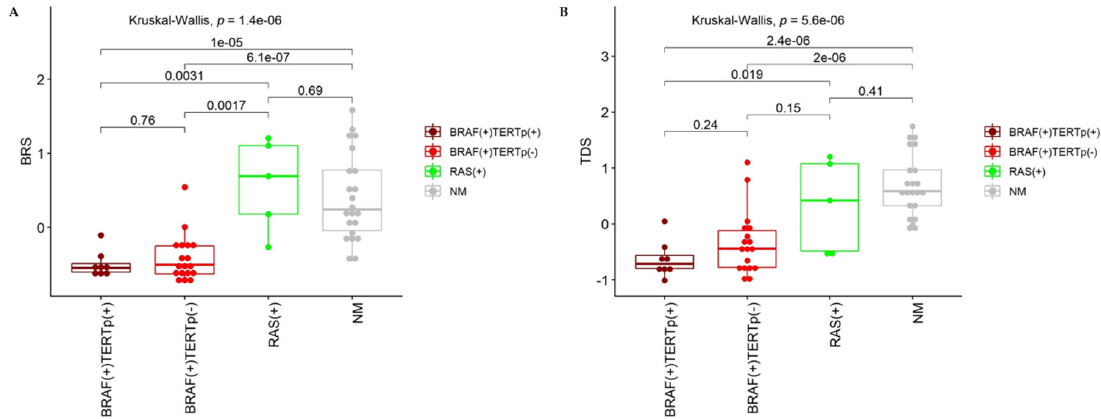
Figure 2. Analysis of BRS ( A ) and TDS ( B ). High BRS depicts RAS ‐ like, whereas low BRS depicts BRAF ‐ like samples. High TDS depicts high expression of thyroid specific genes and high thyroid differentiation. TDS: The Thyroid Differentiation Score, BRS: the BRAF ‐ like RAS ‐ like Score. p ‐ values shown on plots were calculated with Kruskal ‐ Wallis and two ‐ tailed Mann ‐ Whitney tests.